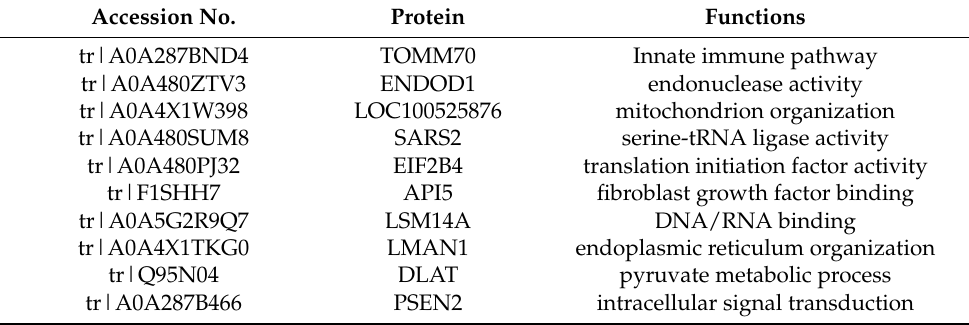
Table 1. Top 10 downregulated proteins down-regulated by PCV 2 Cap digestion.